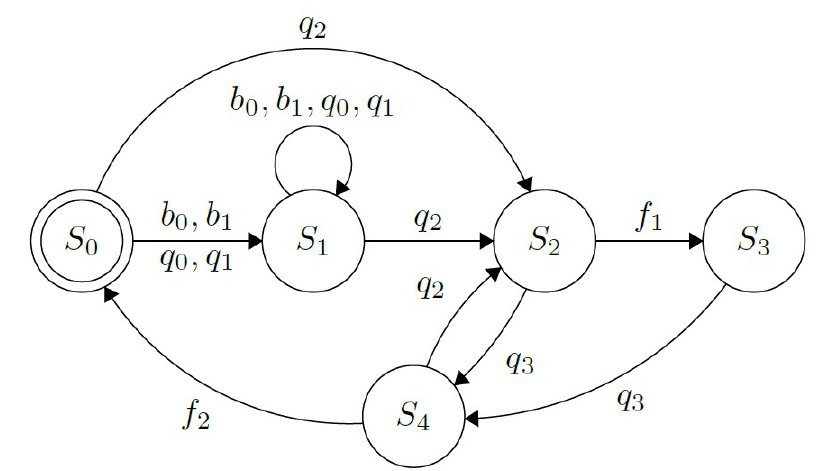
Figure 5. Finite State Machine showing the behavior of the interface using buttons and the Myo to operate. S 0 indicates that the hand is completely open; S 1 , that there was a change in the selected grip; S 2 , that the selected grip is being performed (when it is completed, the flag f 1 is lifted). In addition, S 3 represents that the hand is currently enacting the chosen gesture; while, S 4 , that the fingers are opening (process that informs it is finished by lifting the flag f 2 ).